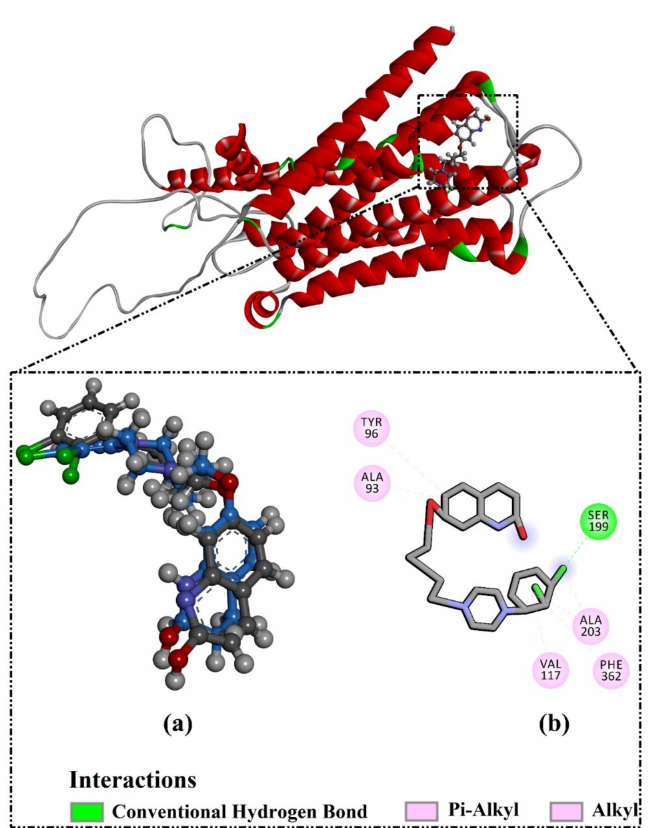
Figure 2. ( a ) A 3D representation of the native structure (gray) and portended docking pose (blue). ( b ) The 2D molecular interactions of the anticipated docking pose of 9SC ligand with 5HT1AR.